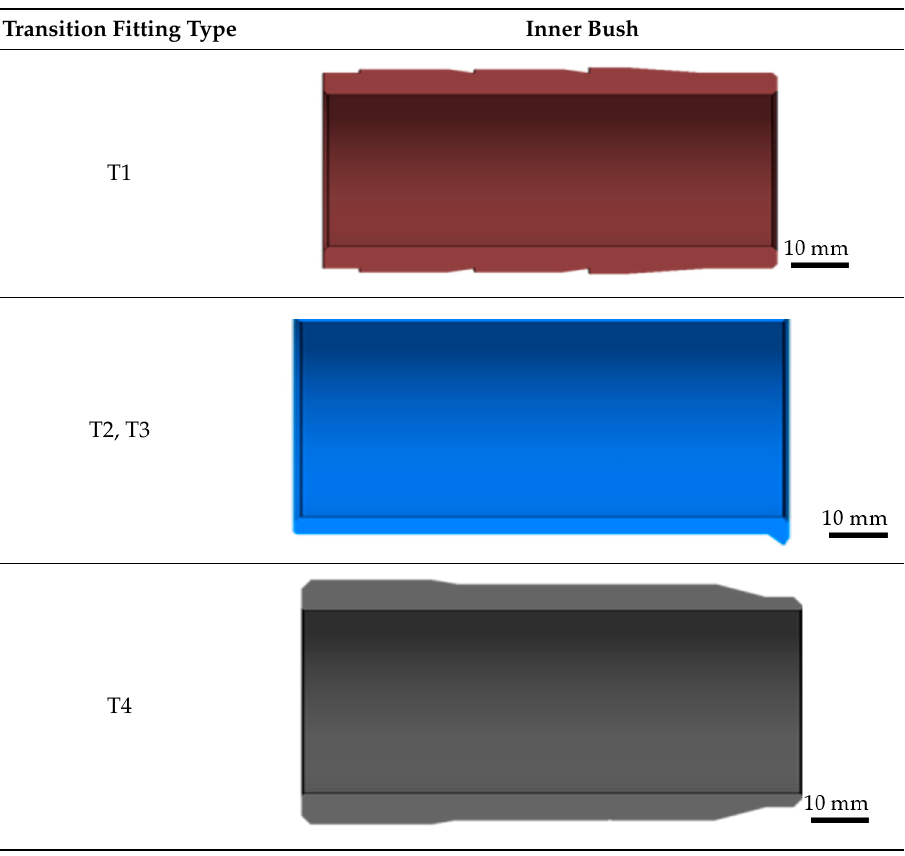
Table 9. The constructive shape of the inner bush.